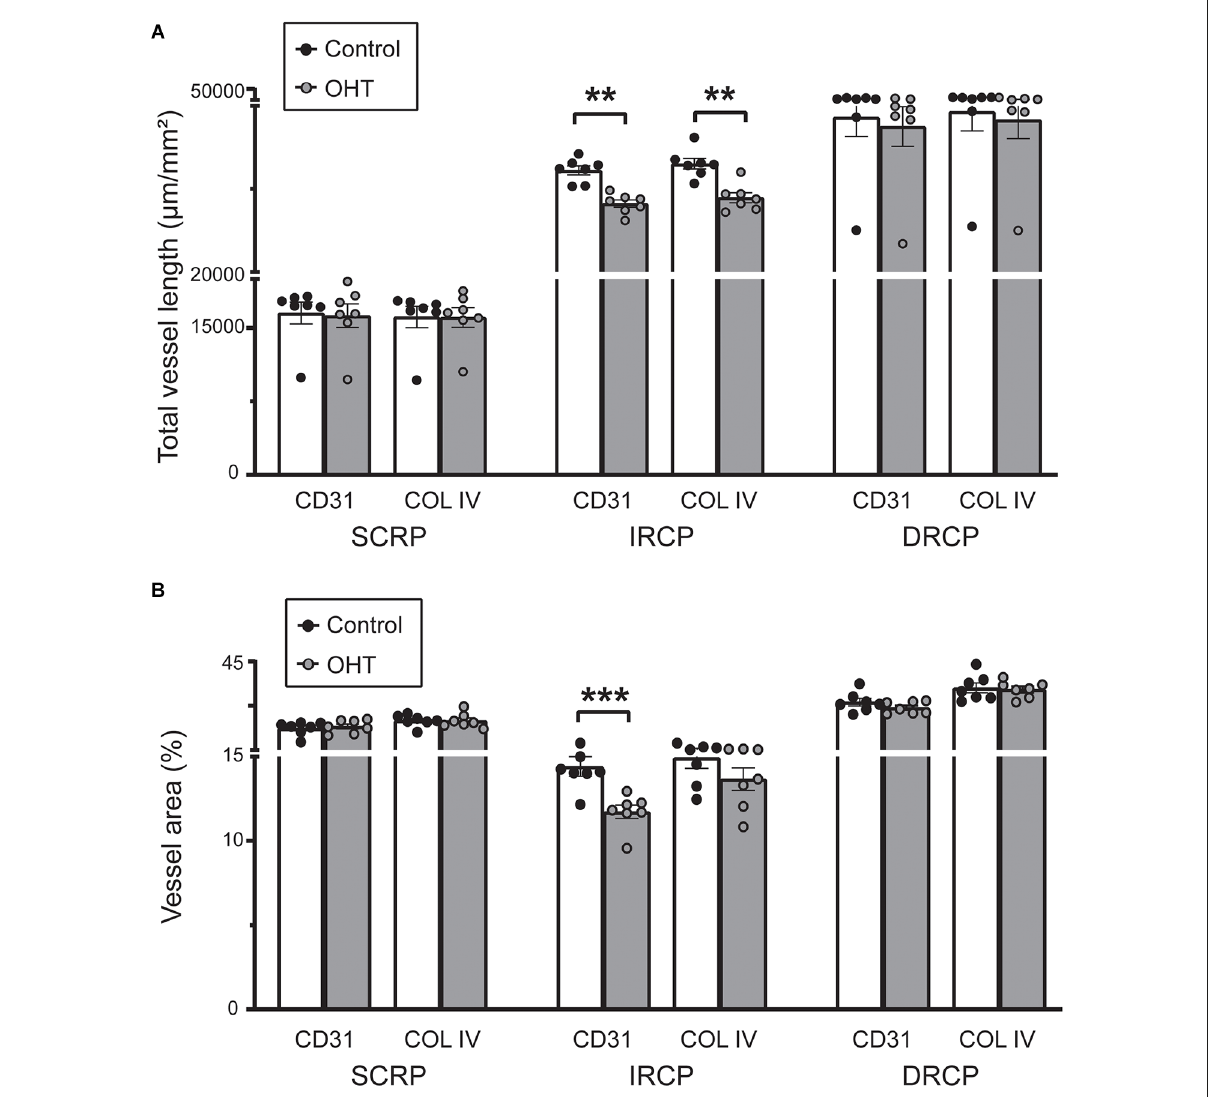
FIGURE4 (A) Total capillary vessel length ( µ m/mm 2 ) in CD31 and Collagen IV immunostained retinas. The total length was reduced for both CD31 and Collagen IV in the IRCP for OHT retinas (paired t -test; ** p < 0.01). No significant changes were seen in the SRCP and DRCP. (B) Percentage of the retina covered by vessels (vessel area %) for CD31 and Collagen IV immunostained retinas. The vessel area percentage was decreased for CD31 but not for Collagen IV in the IRCP for OHT retinas (paired t -test; *** p < 0.001). No significant changes were seen in the SRCP or